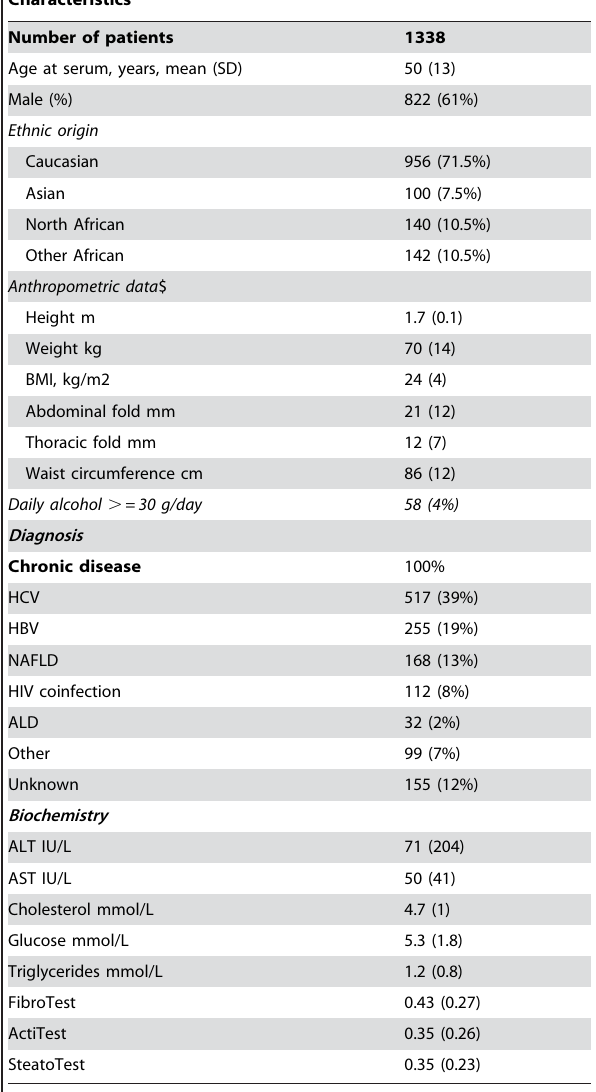
Table 1. Characteristics of included